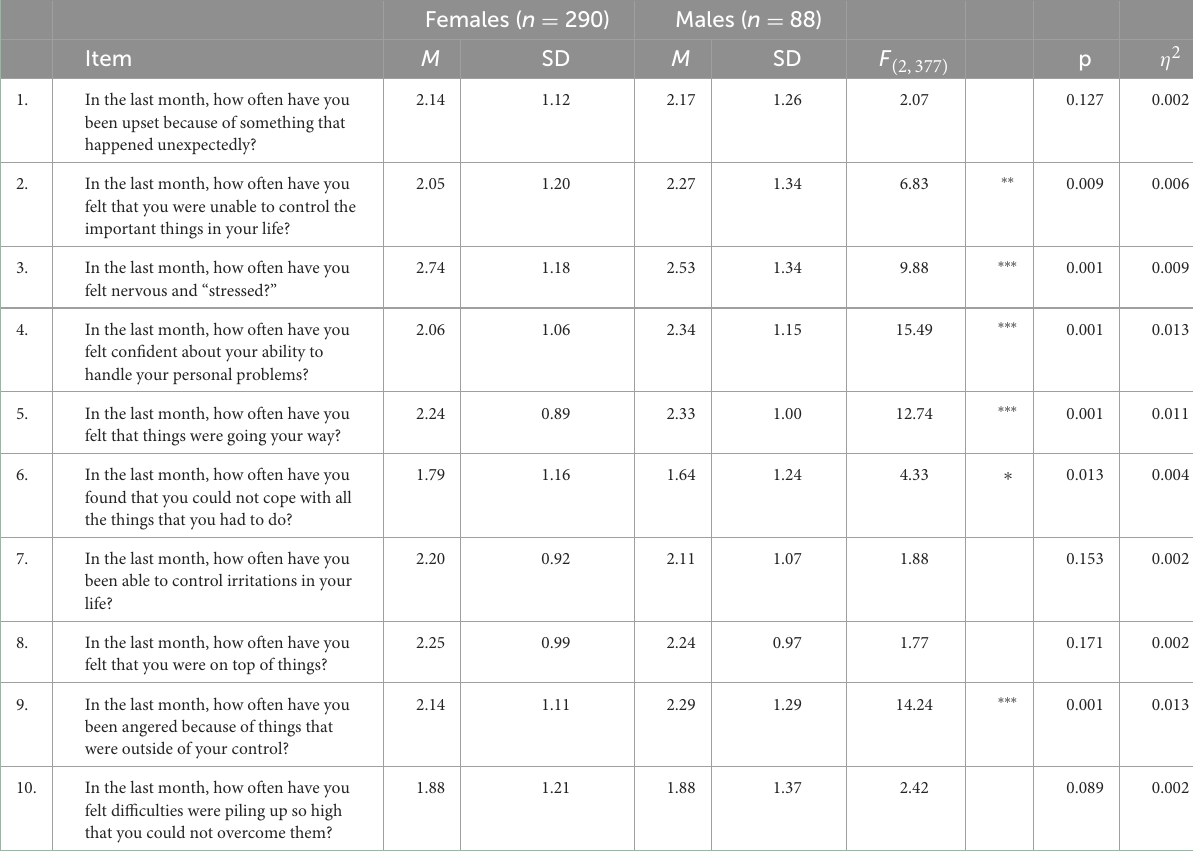
TABLE 3 Gender differences in perceived stress in the last month during COVID-19. Females ( n =